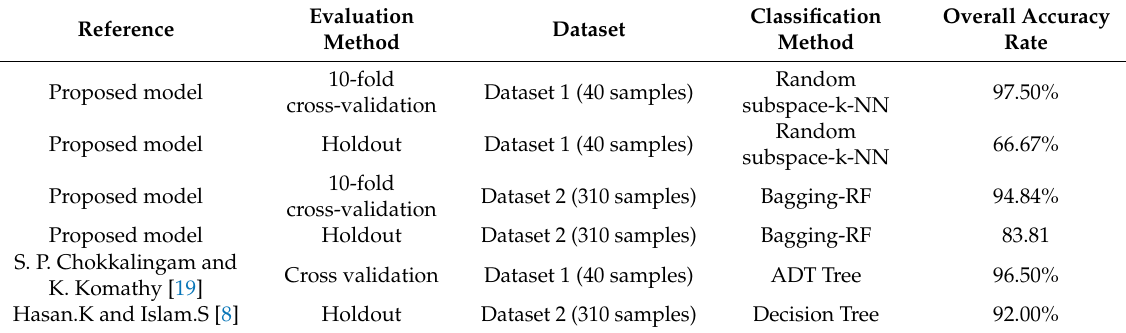
Table 14. Overall classification accuracy comparison with previous research